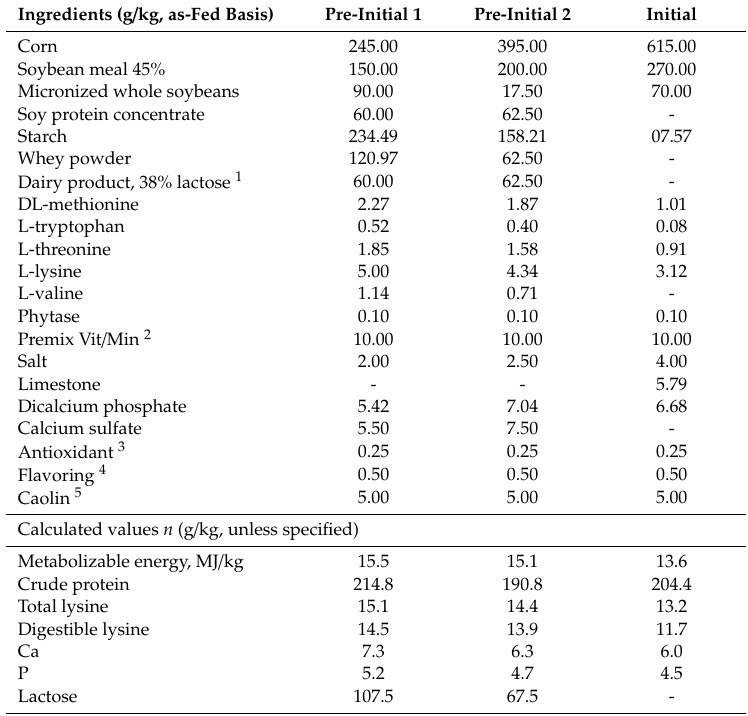
Table 1. Centesimal composition and calculated nutritional values of the diets used in the di ff erent phases of the